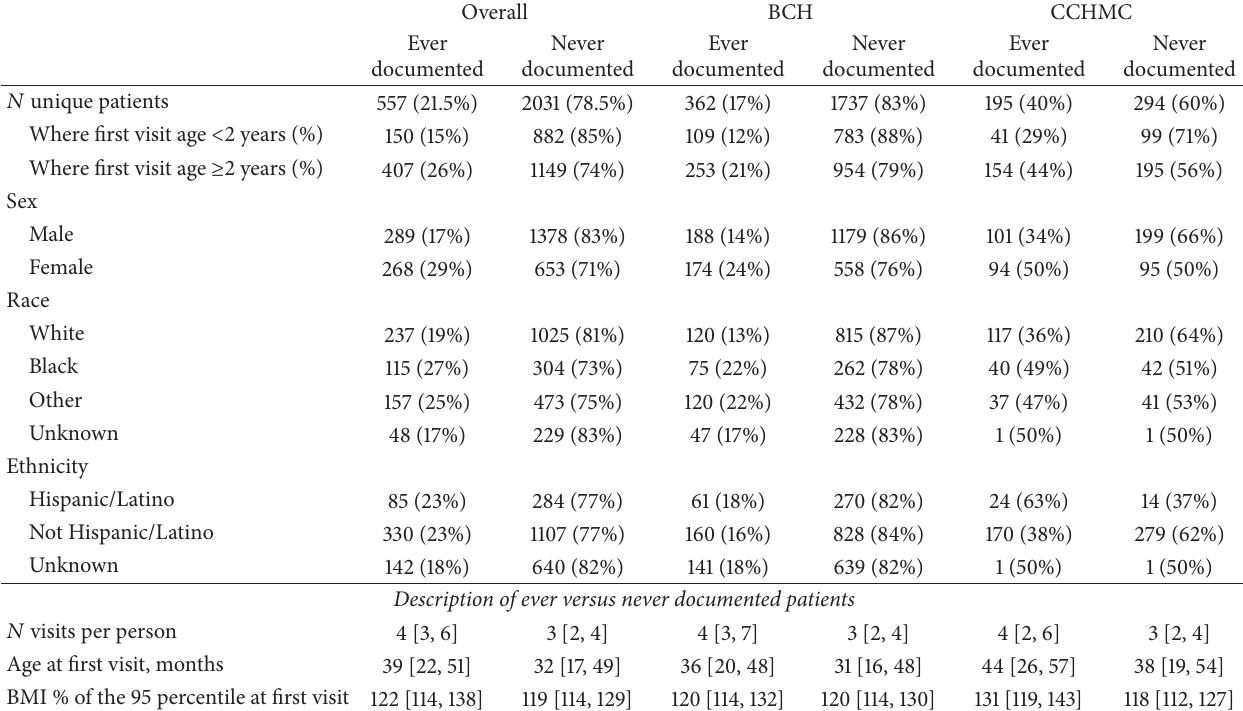
Table 4: Ever documented versus never documented proportions and descriptions by demographic strata.